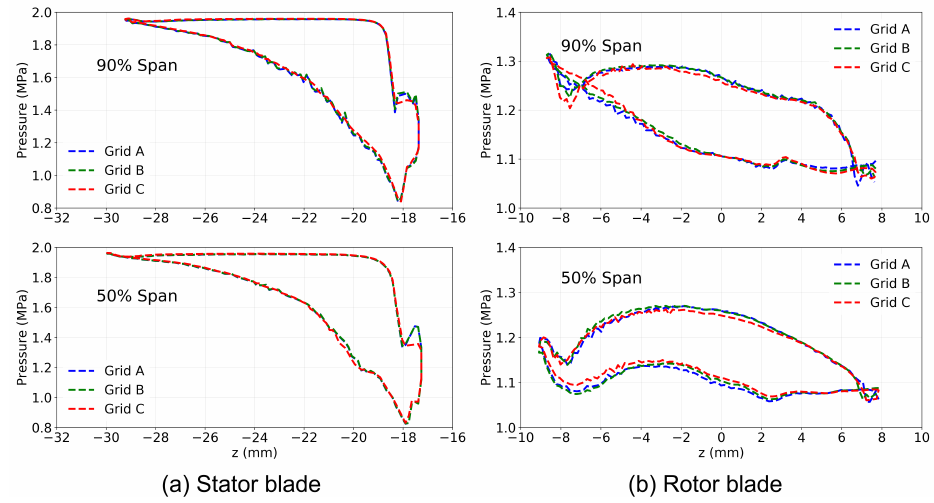
Figure 9. Mean pressure profiles along 50% and 90% spanwise locations for: ( a ) stator blade; and ( b ) rotor